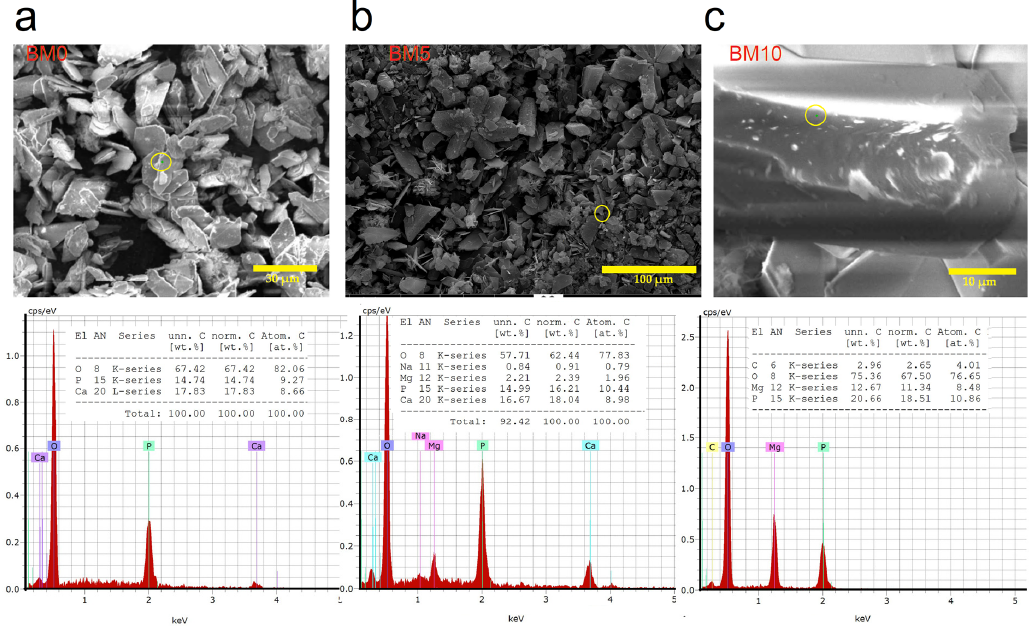
Figure 4. EDS analysis of ( a ) BM0, ( b ) BM5 and ( c ) BM10 compounds.